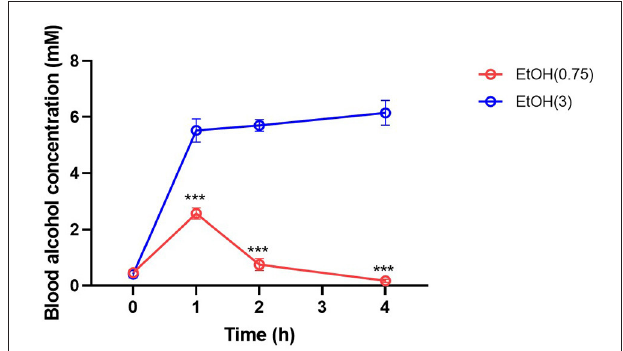
FIGURE 2 | Effect of ethanol administration on blood alcohol concentration. Blood alcohol concentration was determined on 0, 1, 2, and 4h post-administration by measuring the ethanol level in serum samples. Values are shown as mean ± SEM ( n = 4). *** p < 0.001 as compared to EtOH (0.75) group.